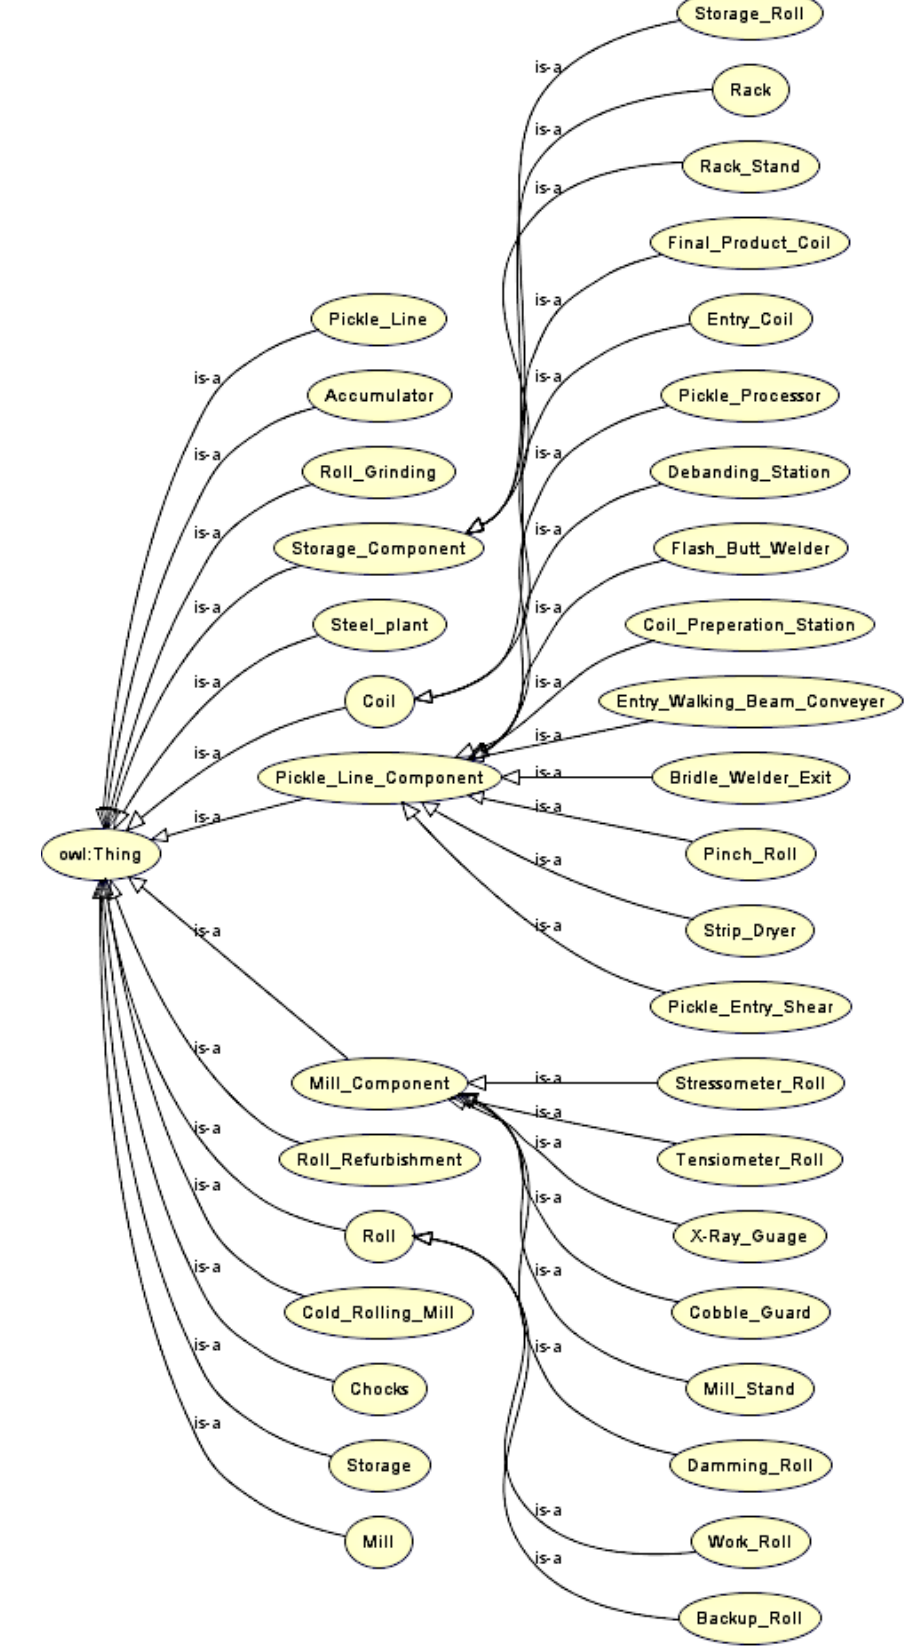
Figure 4. Hierarchy of all the classes in SCRO generated by OWLViz plugin in